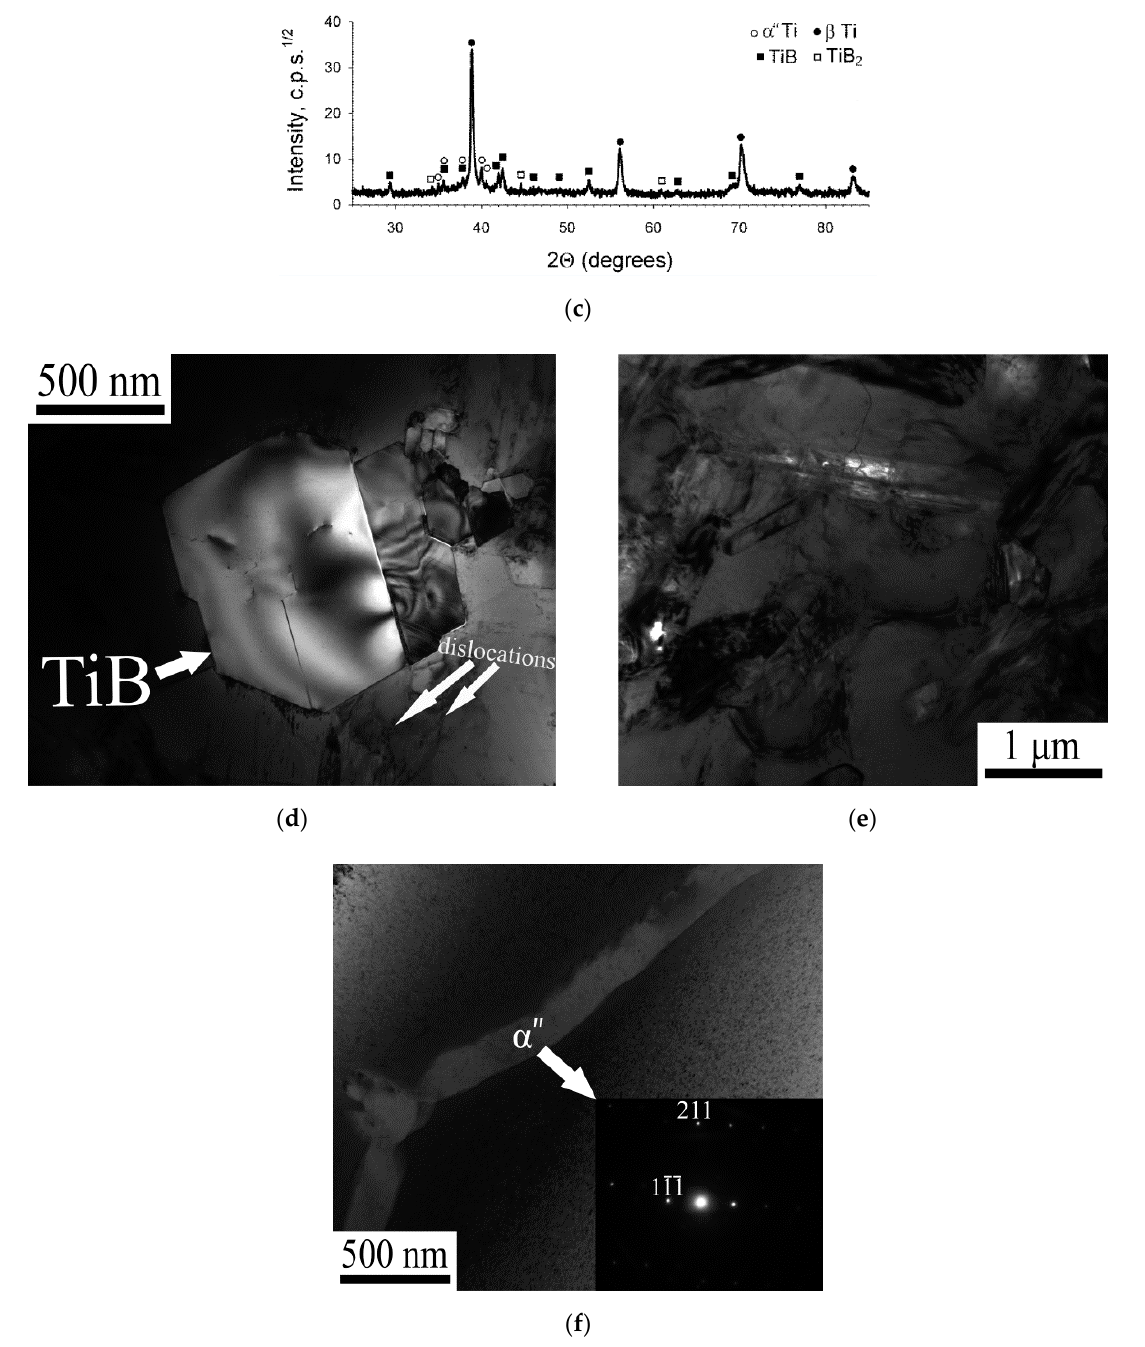
Figure 1. Microstructure of Ti-15%Mo/TiB composite in the initial condition: ( a ) SEM image of unetched surface; ( b ) SEM image of etched surface; ( c )—XRD pattern; ( d , e ) TEM bright field images; ( f ) TEM bright field image and a diffraction pattern (inserted) obtained from the α ’’ phase.